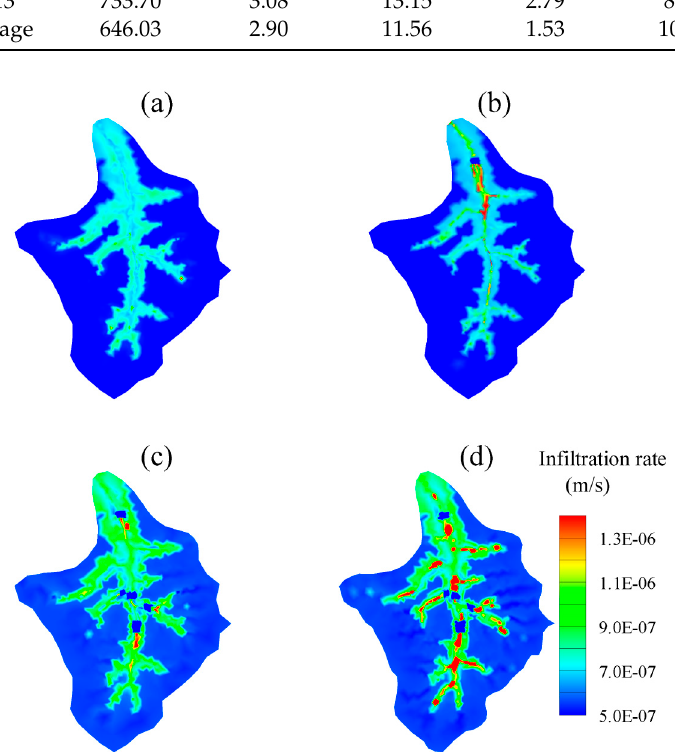
Figure 7. Snapshots of infiltration rate at the time of peak discharge of four events with similar rainfall characteristics extracted from the four scenarios, respectively. ( a ) PD scenario; ( b ) SD scenario; ( c ) EDS scenario; ( d ) CDS scenario.